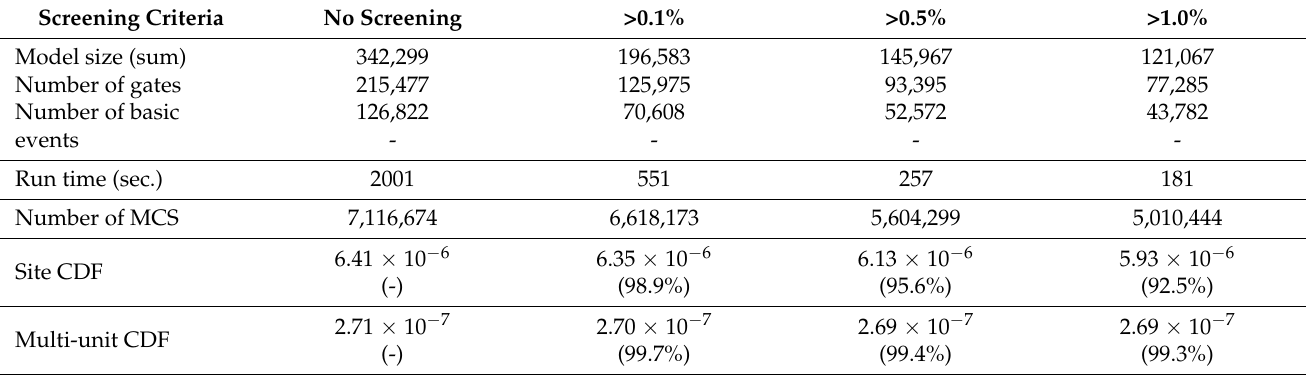
Table 5. Comparison of quantification results by screening criteria for the 6U-LOOP model. Screening